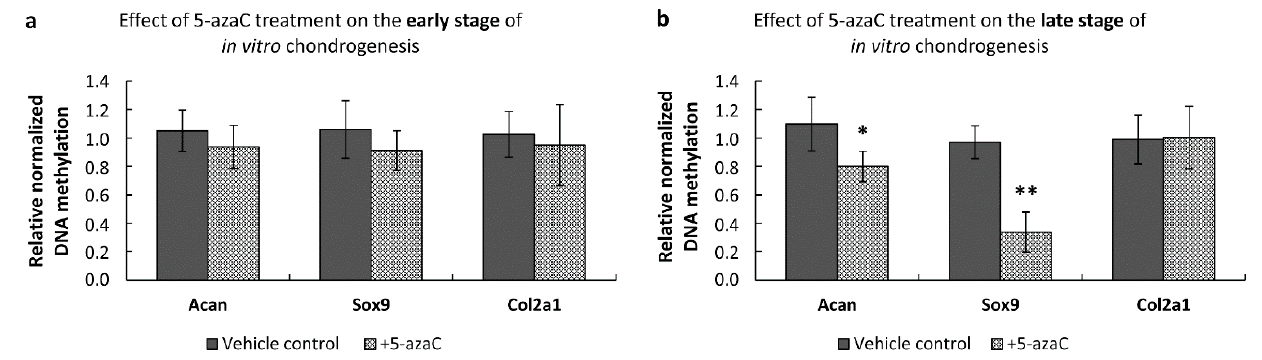
Figure 7. Methylation status of the promoters of cartilage-specific marker genes in primary chondrifying micromass cultures after 5-azaC treatment. ( a ) Changes of the DNA methylation profiles during the early stage of chondrogenesis, where 5-azaC was administered from the 1st day of culturing for 72 h, and cultures were harvested on culturing day 4. ( b ) Changes in DNA methylation during the late stage of chondrogenesis: 5-azaC was applied from the 3rd day of culturing for 72 h, samples were harvested on culturing day 6. TATA box binding protein (TBP) promoter served as a negative control, and the qPCR data sets were normalized against the TBP promoter-specific unmethylated MSP primers. Data are expressed as the mean ± SEM. Statistically significant differences of methylation levels are indicated by asterisks as follows: * p < 0.05; ** p < 0.01. One-Way ANOVA with Tukey HSD was employed for evaluating significance.